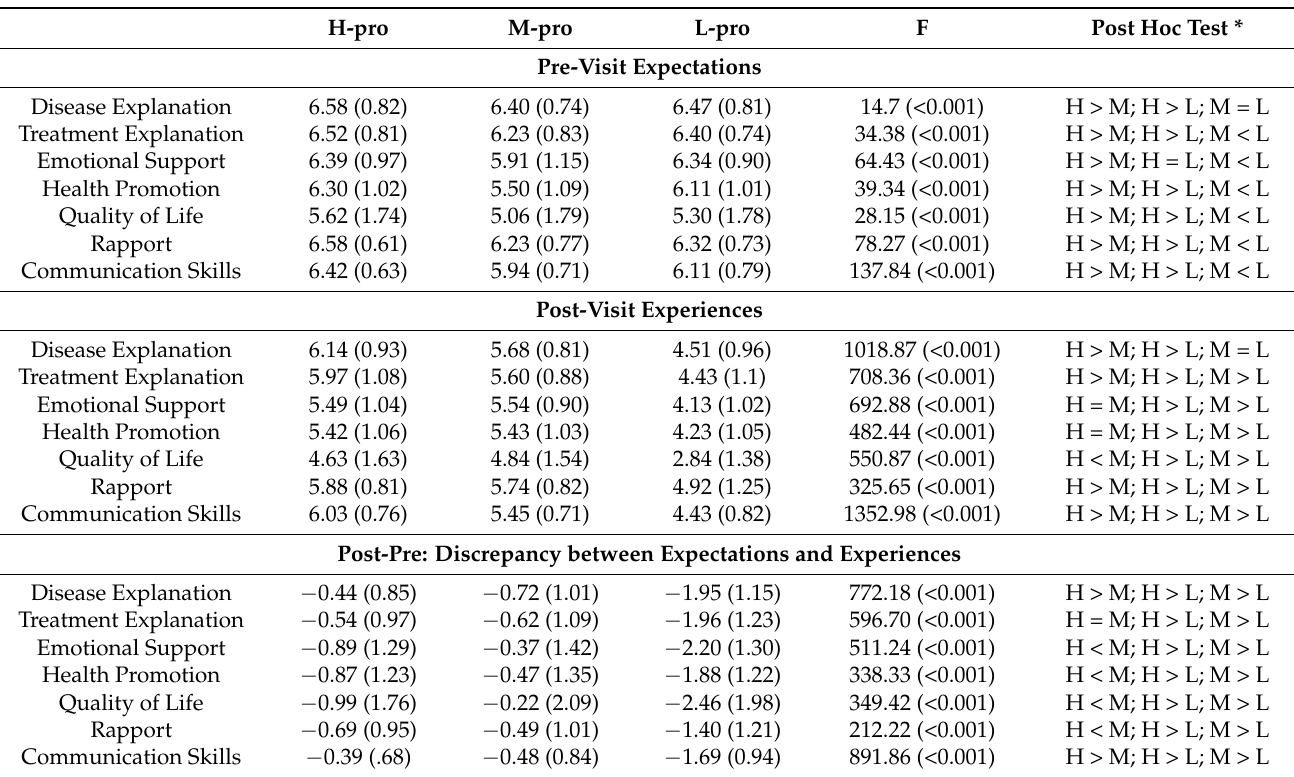
Table 3. Differences between health proactivity profiles according to pre-visit expectations and visit